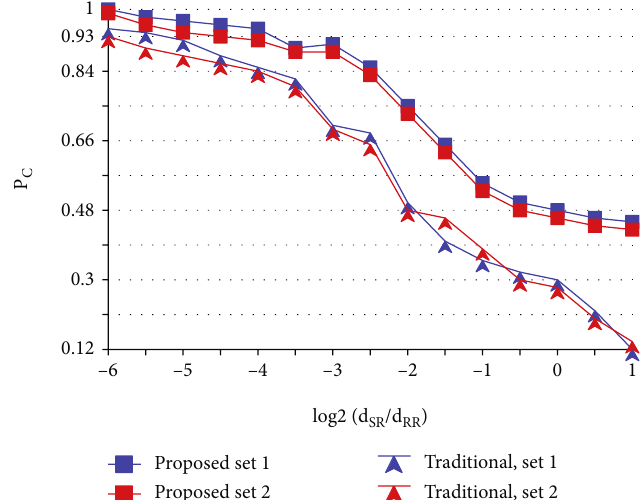
Figure 5: In fl uence of distance on the algorithm based on likelihood